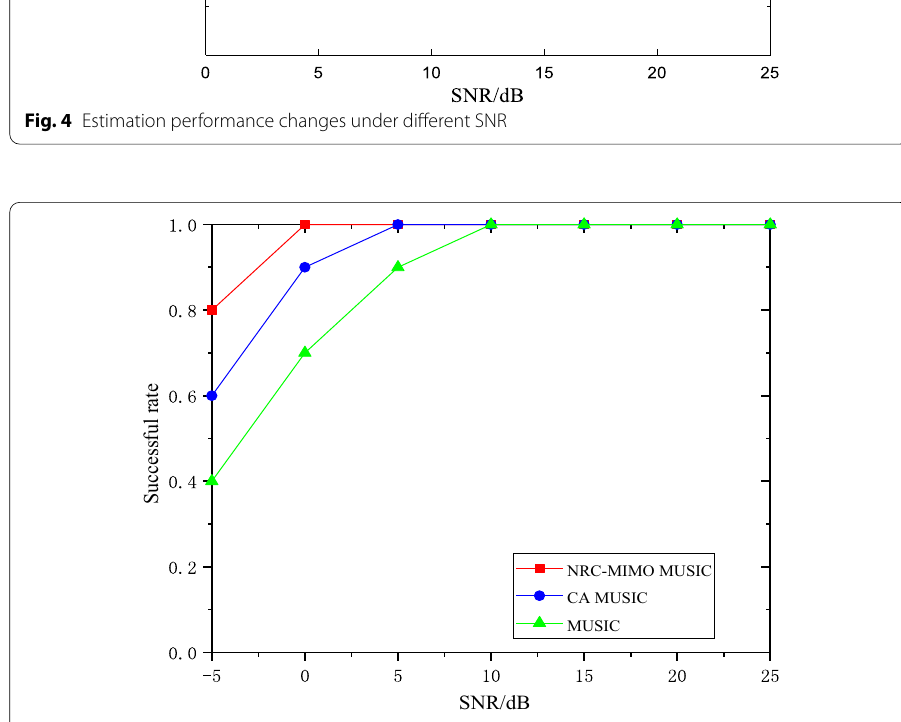
Fig. 5 The target detection success rate varies with